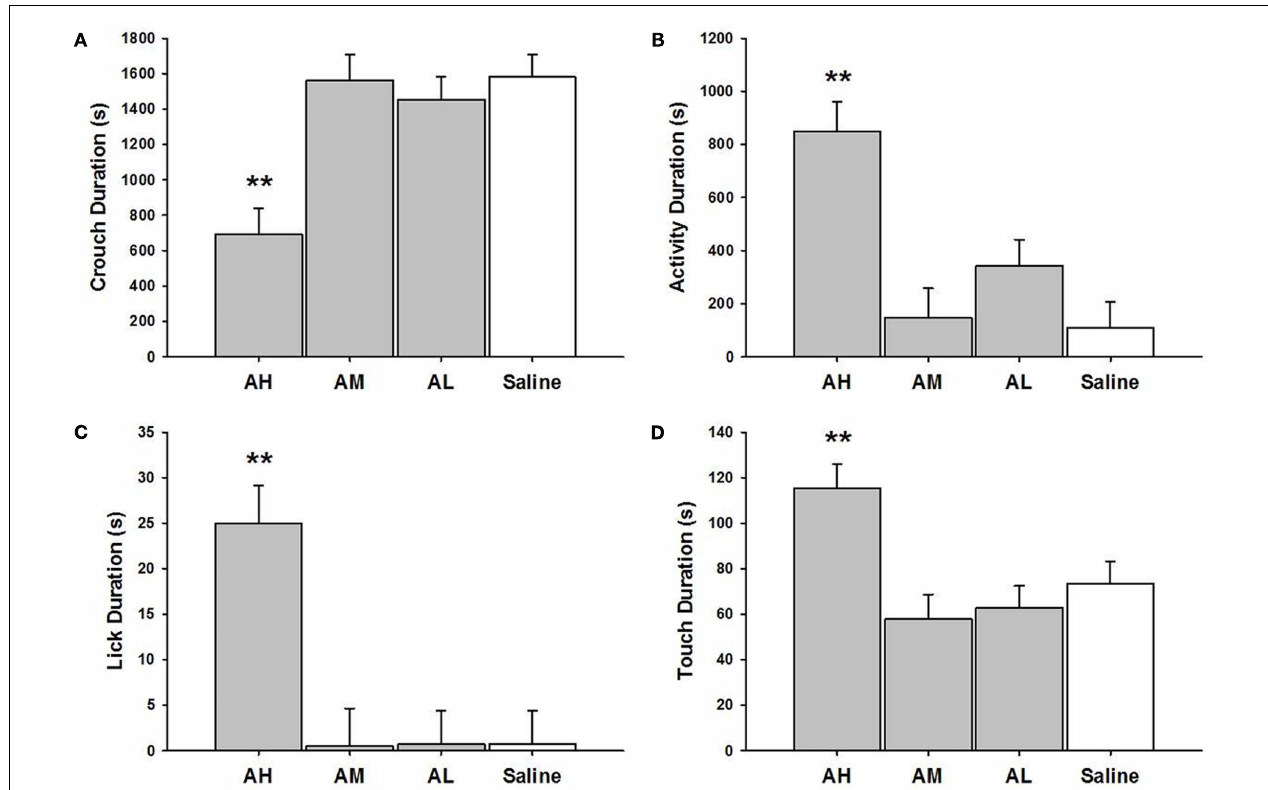
FIGURE 1 | Mean ± SEM of all MB measures organized in four panels of bar charts for all amitriptyline groups. Each panel is for a specific behavior [ (A) Crouch; (B) Activity; (C) Lick; (D) Touch]. All four panels measure duration in seconds (s) on the Y axis and X axis includes categories for all amitriptyline